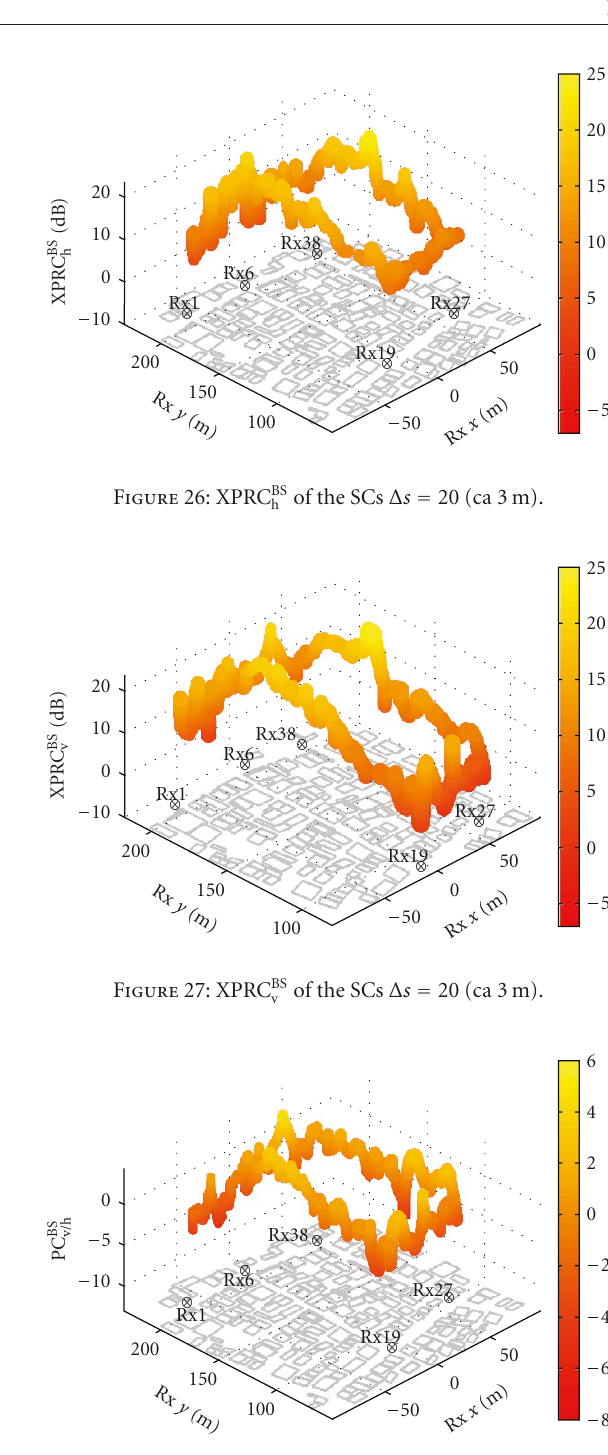
Figure 28: PC BS of the SCs Δ s = 20 (ca 3m). v/h